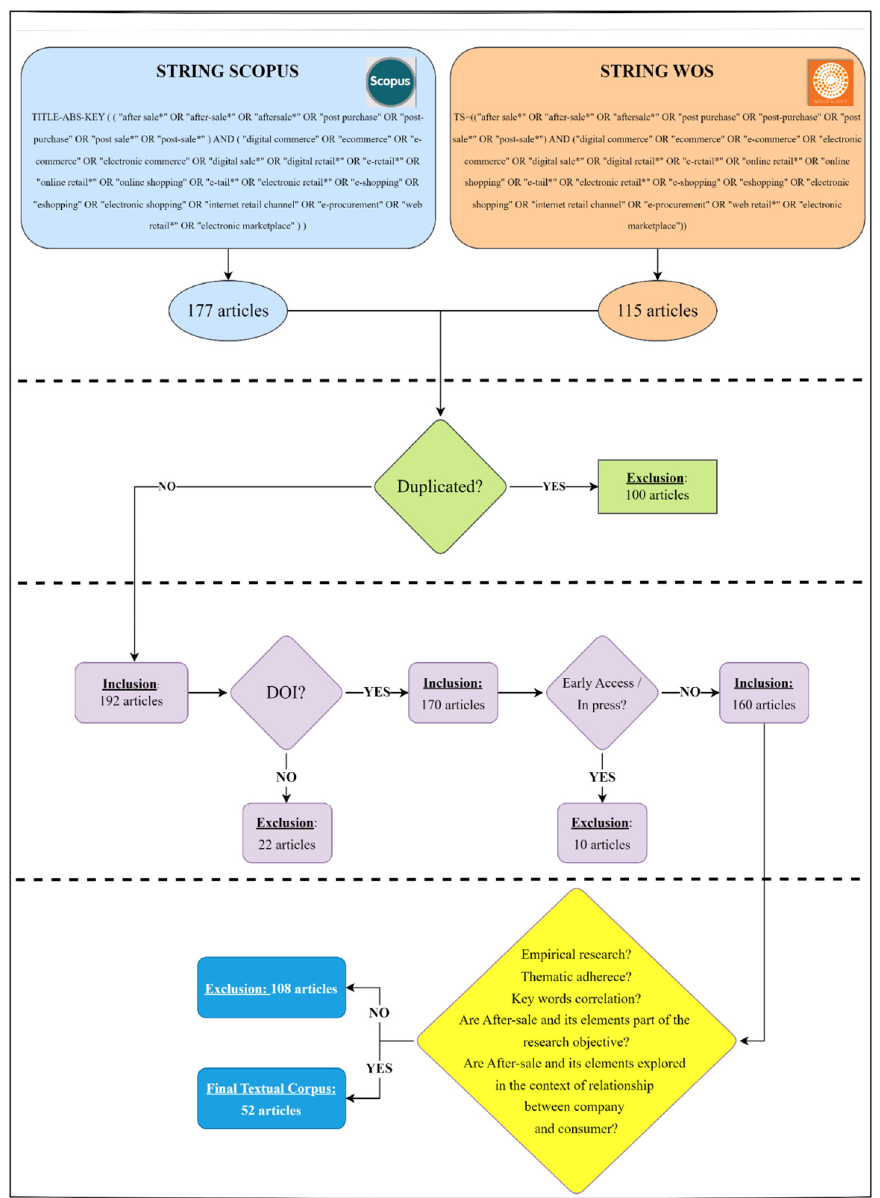
Figure 1. Diagram summarizing the methodology of the systematic